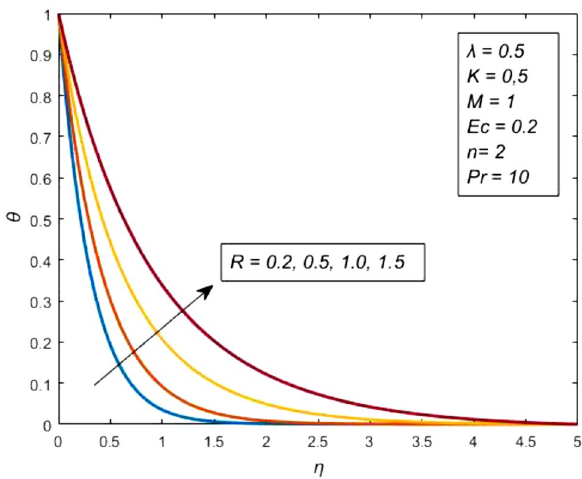
Figure 7. Impact of radiation parameter R on the temperature profile.